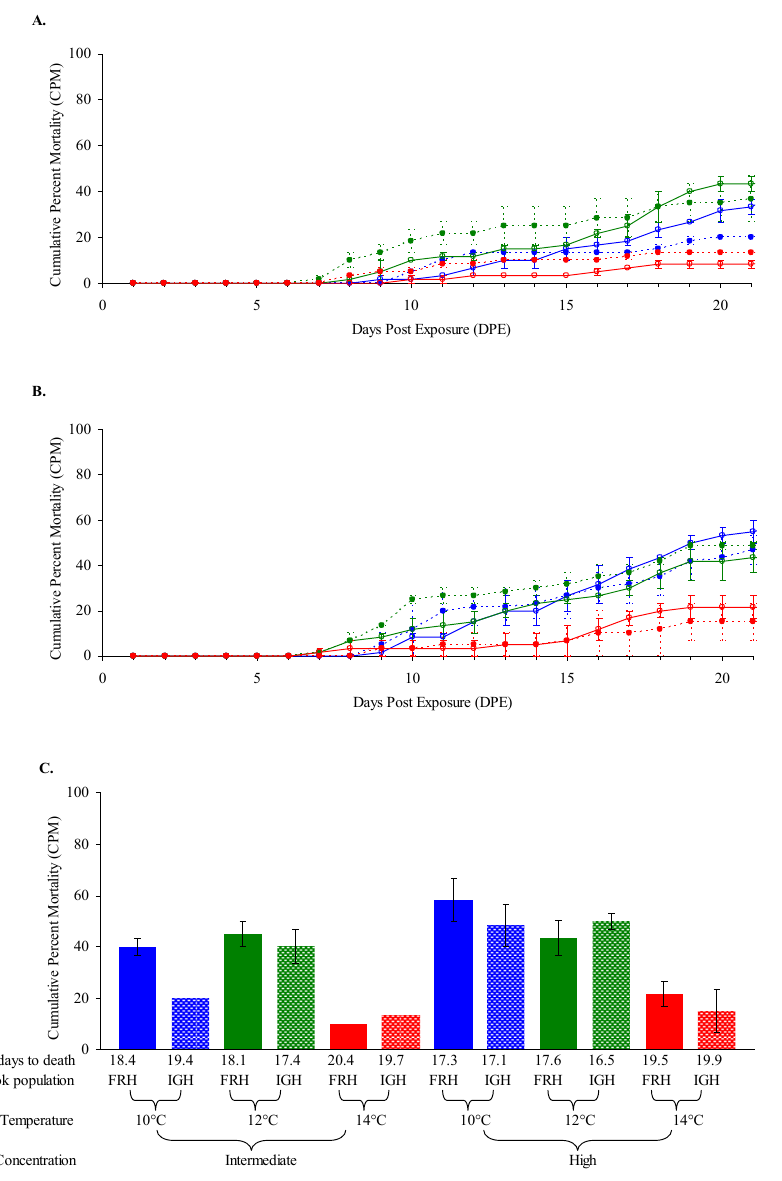
Figure 2. Mortality of Chinook salmon fingerlings exposed to IHNV at three temperatures. Aver- age daily cumulative percent mortality (CPM) for duplicate groups of 30 Feather River Hatchery (FRH) Chinook salmon (solid line) and Iron Gate Hatchery (IGH) Chinook salmon (broken line) fingerlings (ave. 2.2 g) after waterborne exposure to ( A ) intermediate and ( B ) high doses of infectious hematopoietic necrosis virus subgroup LII isolate FR04 at water temperatures of 10 ◦ C (blue), 12 ◦ C (green) and 14 ◦ C (red). Actual exposure doses determined on the day of challenge were 7.0 × 10 5 and 7.0 × 10 6 pfu mL − 1 . ( C ) Bars show average CPM ( ± SE) in duplicate treatment groups. Absence of SE bars indicates that duplicate groups had identical